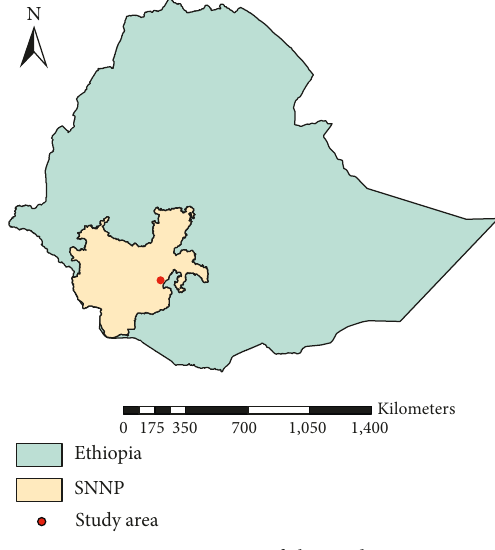
Figure 1: Location of the study